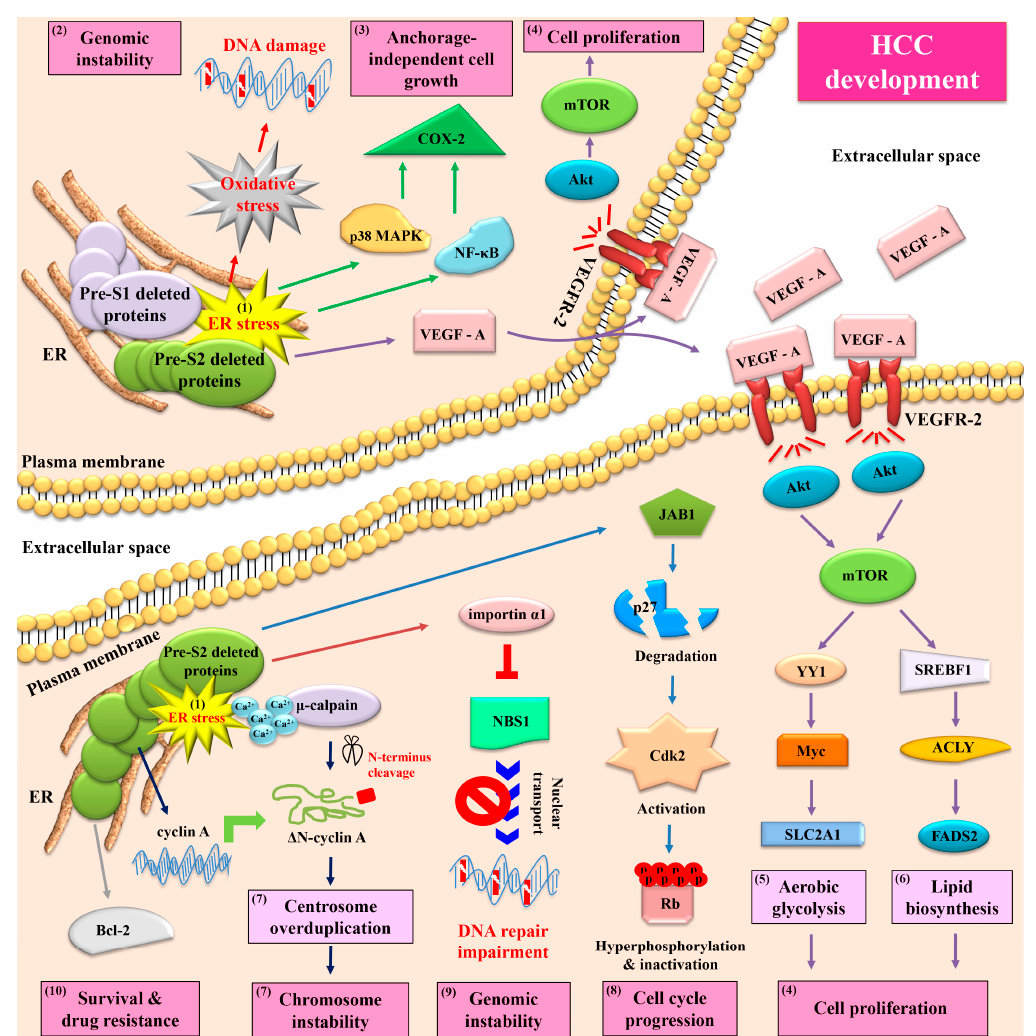
Figure 4. Schematic summary of signaling pathways activated by HBV pre-S deleted proteins and their implications